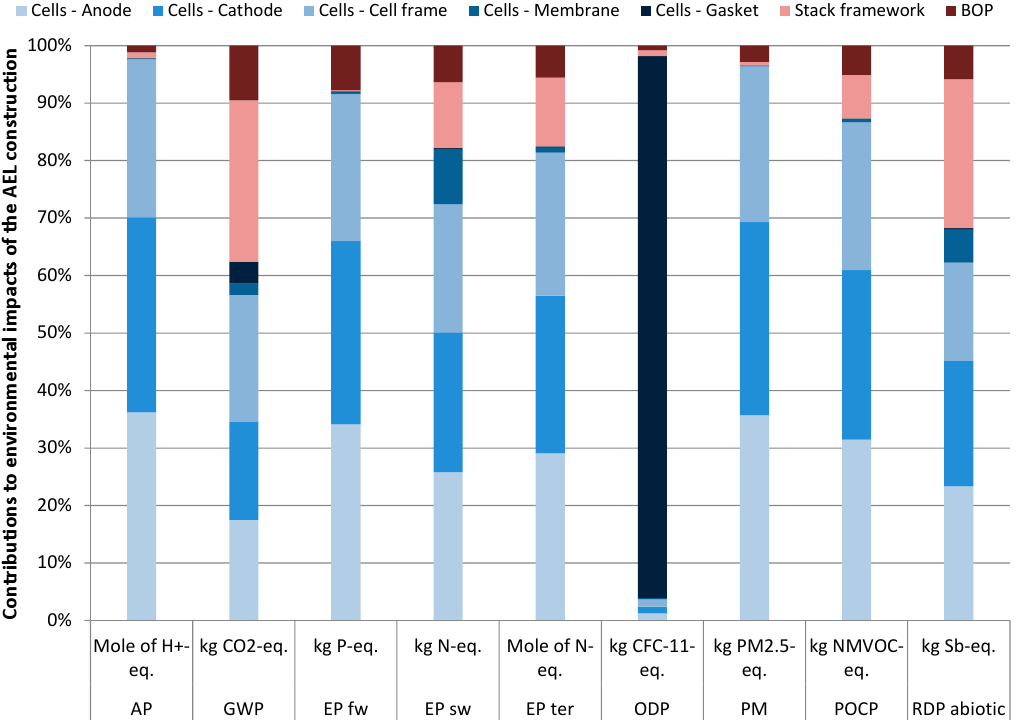
Figure 5. Relative contributions to environmental impacts of the construction phase.